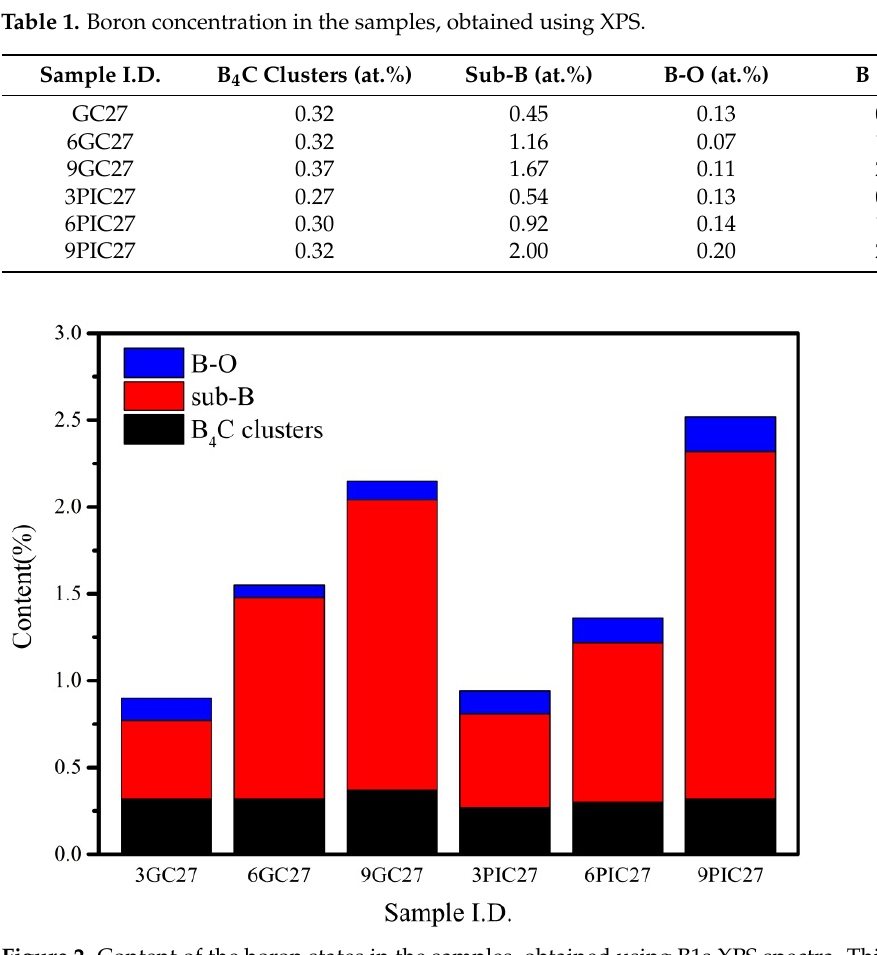
Figure 2. Content of the boron states in the samples, obtained using B1s XPS spectra. This chart is a visualization of the data in Table 1. Table 2. Interlayer spacings (d 002 ) of the samples